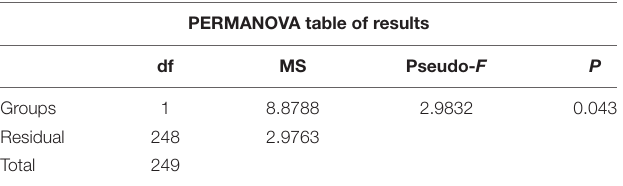
TABLE 1 | Results of PERMANOVA based on Euclidean distance matrices derived from log-transformed environmental data between 2016 and 2019. PERMANOVA table of